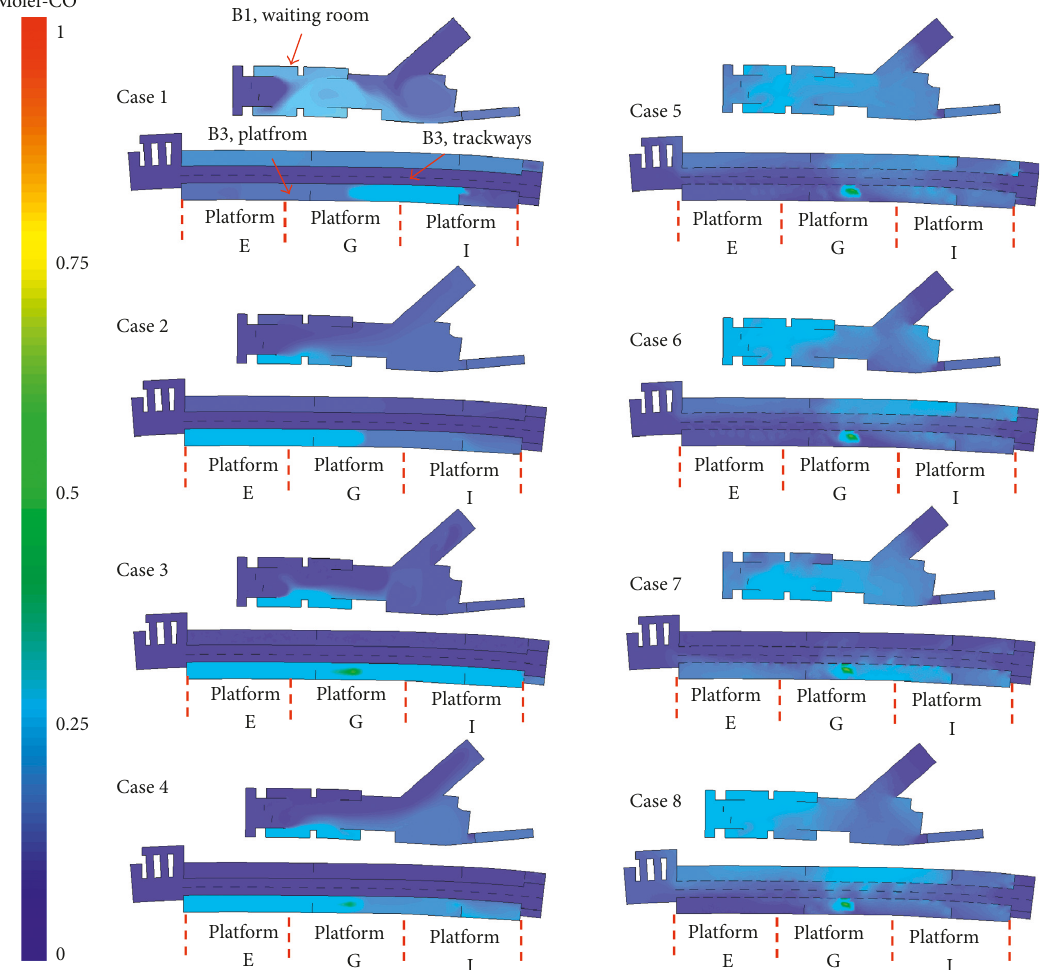
Figure 4: CO contours of underground subway station at the height of